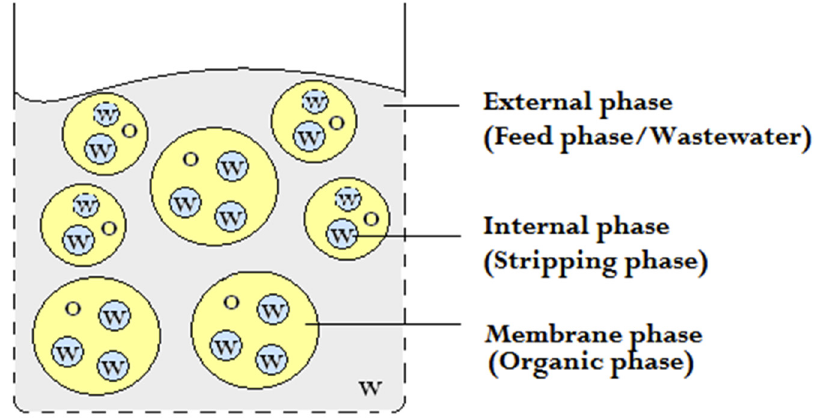
Figure 1. The phases in a water-in-oil-in-water emulsion (w/o/w). O = Oil (Yellow) and W = Water (Gray for external phase and blue for interal